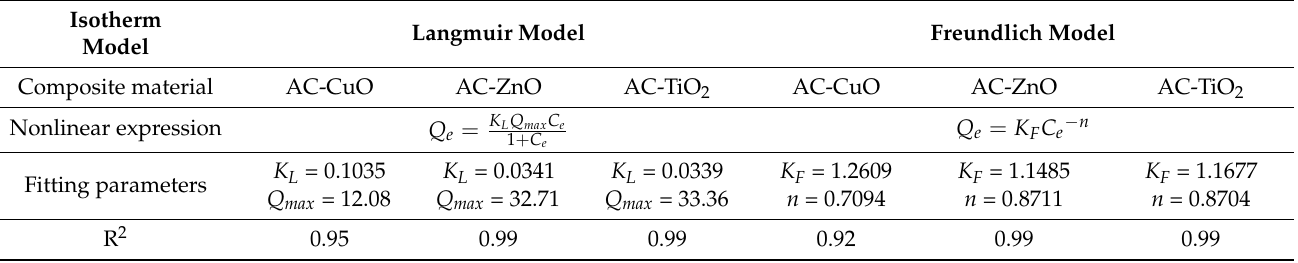
Table 6. Summary of correlation coefficients for kinetic model fitting.